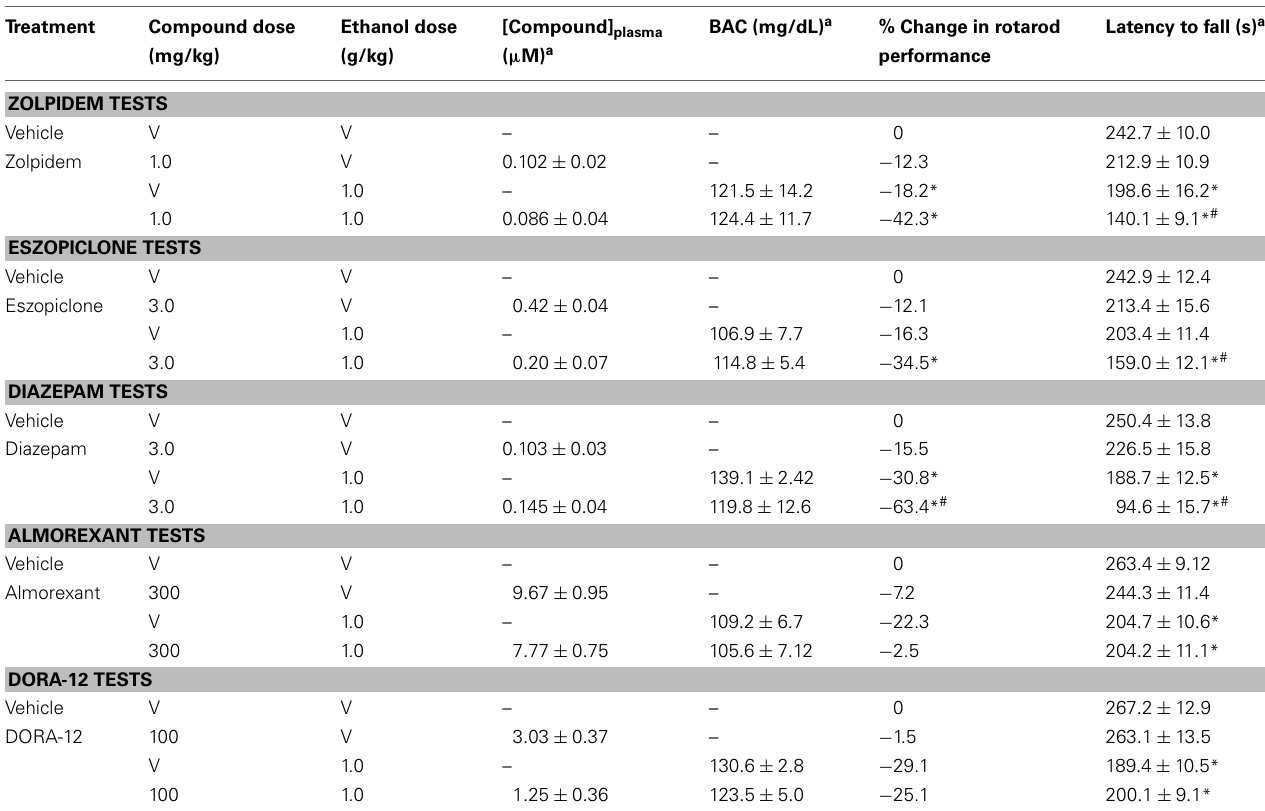
Table 2 | Interaction of GABA-A receptor modulators and orexin receptor antagonists combined with a minimum effective dose of ethanol on drug plasma concentration, blood alcohol concentrations and latency to fall from the